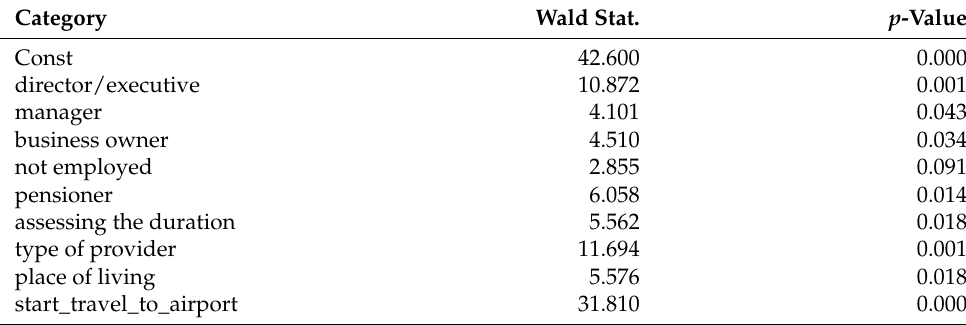
Table 7. General results for ordered logit model for sustainable travel choices of passengers going to the airport.